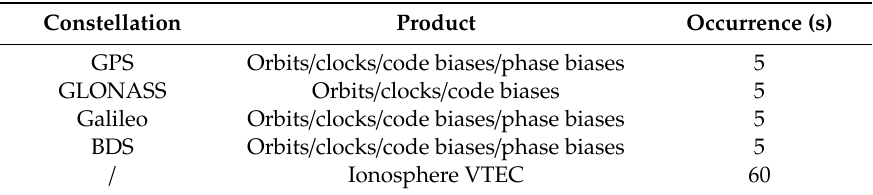
Table 1. Messages provided by